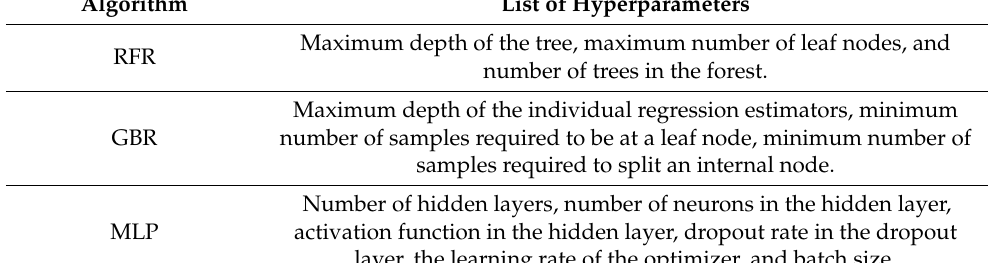
Table 3. List of hyperparameters that were tuned for each ML-based algorithm.